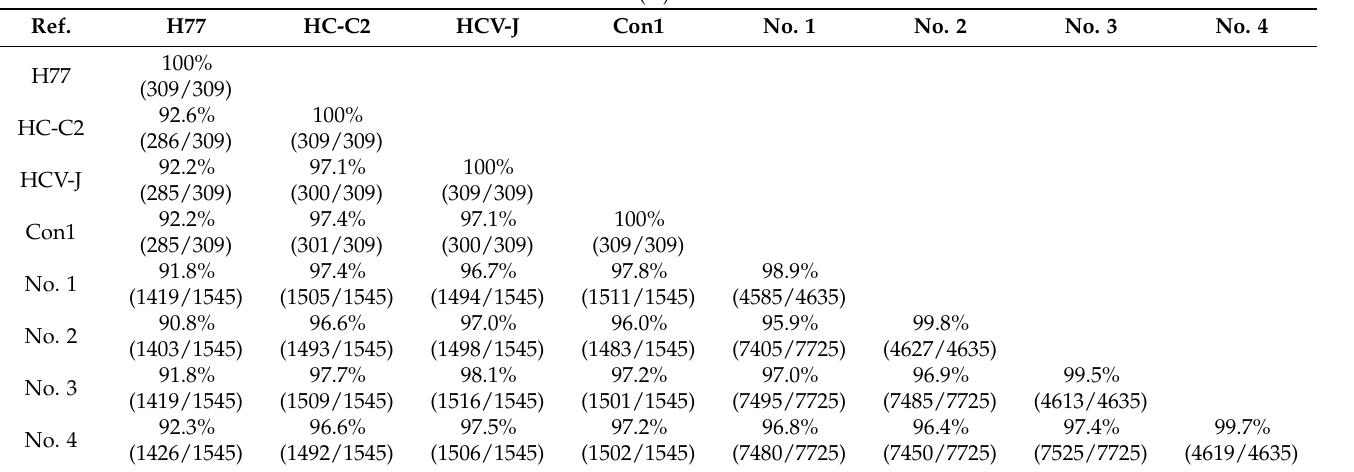
Table 3. Comparison between HCV core nucleotide sequences obtained from discrepant samples and reference sequences (Ref.) specific for each genotype by cloned Sanger sequencing. ( A ) Identity between core nucleotide sequences of genotype 1b obtained by sequencing (5 clones) and reference sequences of genotype 1 (1a and 1b); ( B ) Identity between core nucleotide sequences of genotype 2a obtained by sequencing (5 clones) and reference sequences of genotype 2a; ( C ) Identity between core nucleotide sequences of genotype 2b obtained by sequencing (5 clones) and reference sequences of genotype